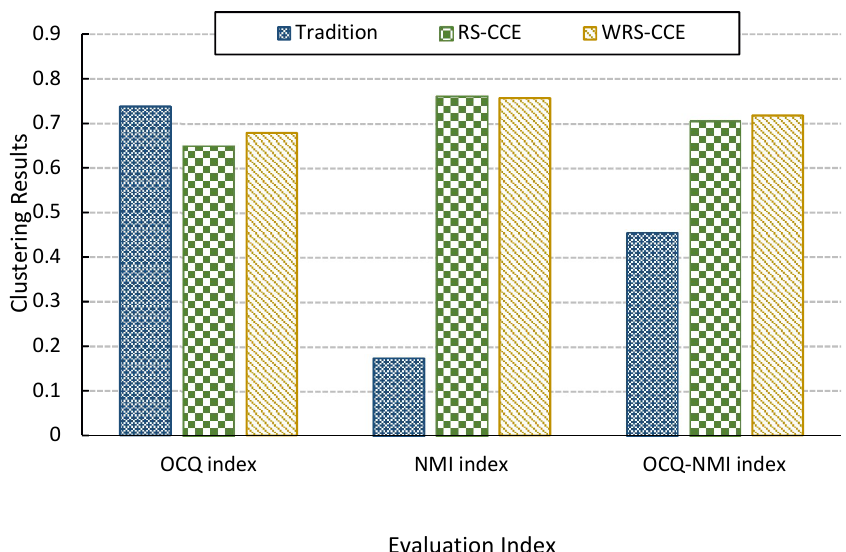
Figure 7. Comparison of traditional construction method, constructing clustering ensembles by random sampling (RS-CCE) and clustering ensemble construction algorithm with weighted random sampling (WRS-CCE) clustering effect.